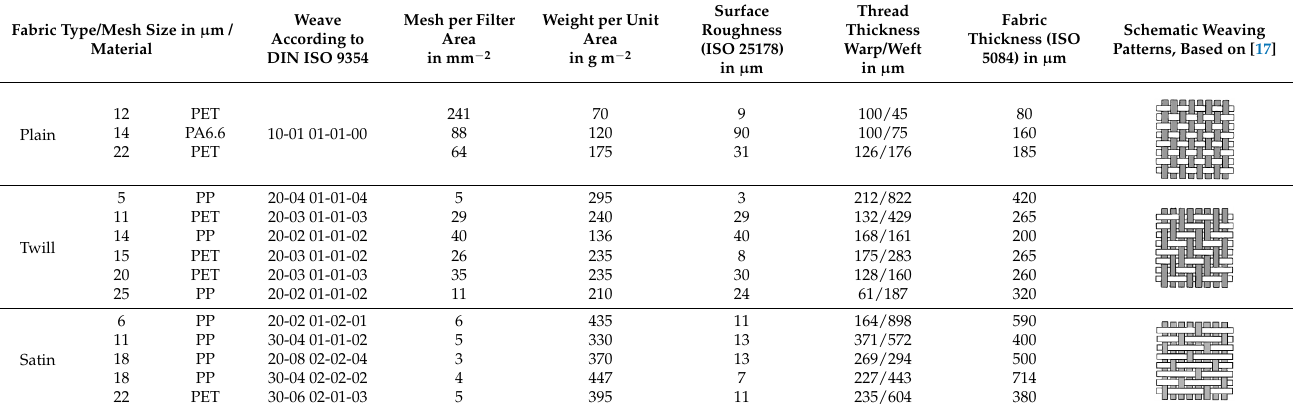
Table 1. Overview of polymer-based monofilament fabrics.